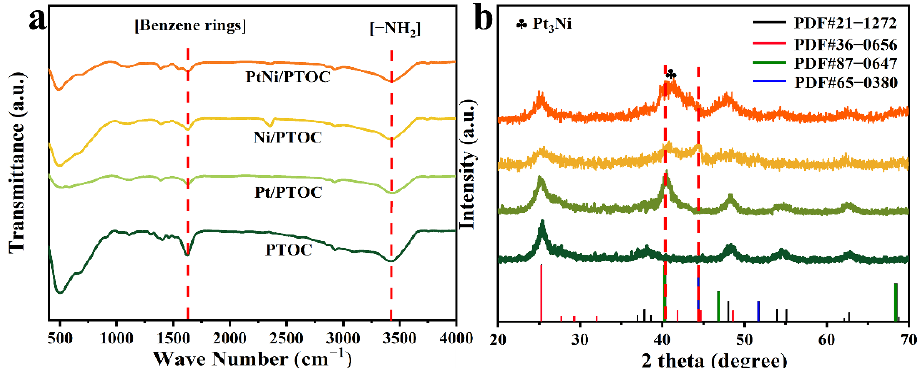
Figure 4. ( a ) FTIR spectra of catalysts. ( b ) XRD patterns of catalysts.